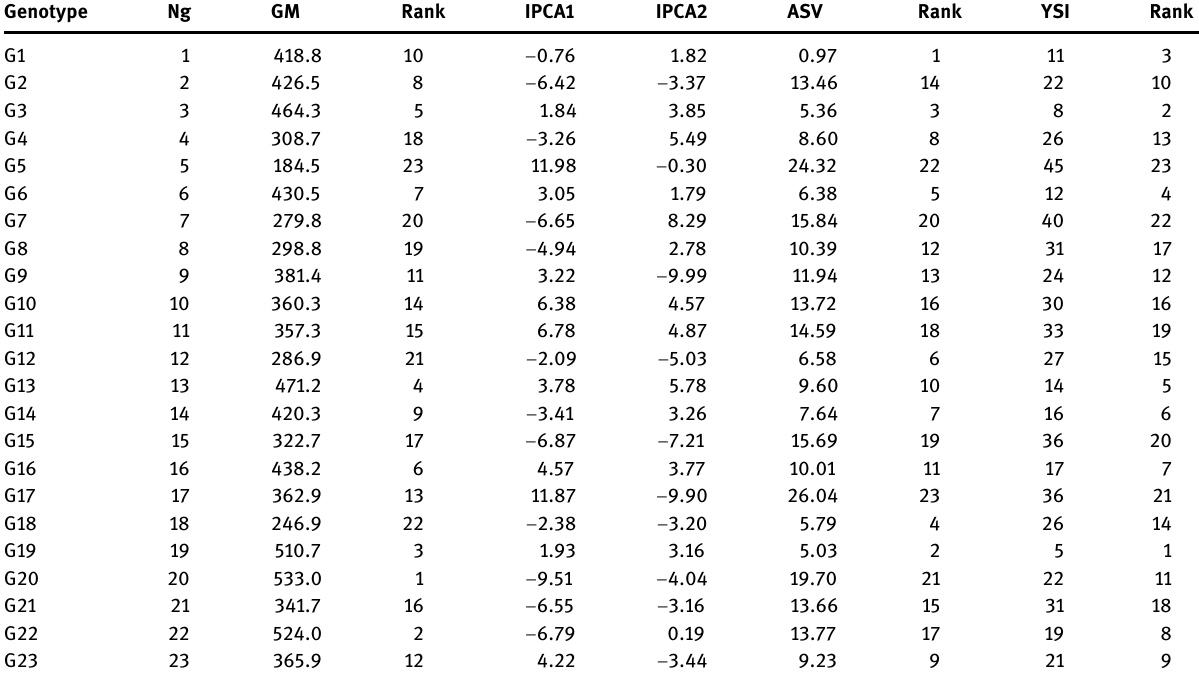
Table 5: AYB genotypes mean performance ranking, IPCA 1 and 2 scores, and yield selection indices Genotype